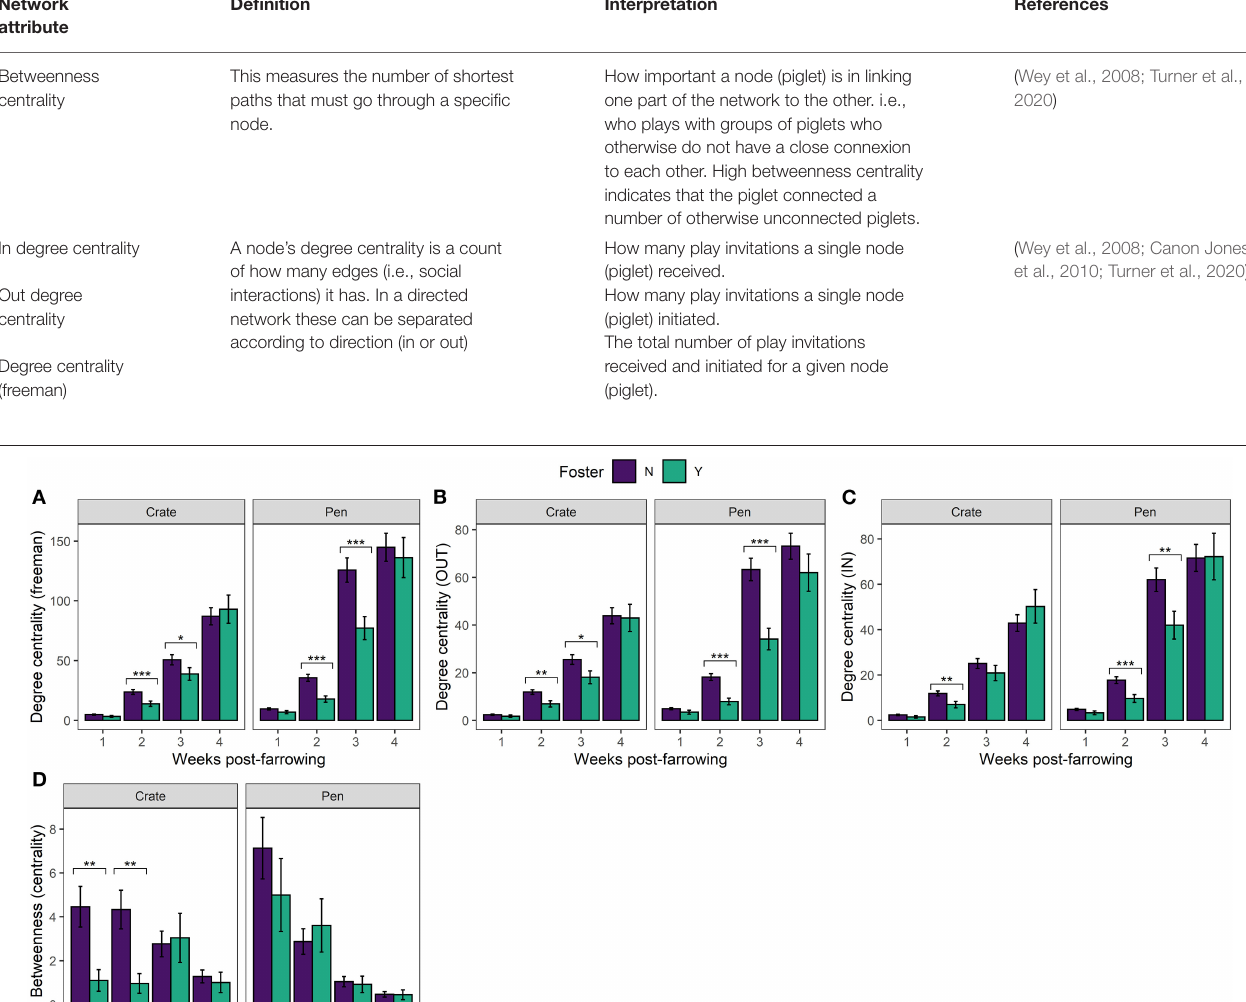
TABLE 2 | Definitions of key network analyses attributes from social network theory and their interpretation in relation to our